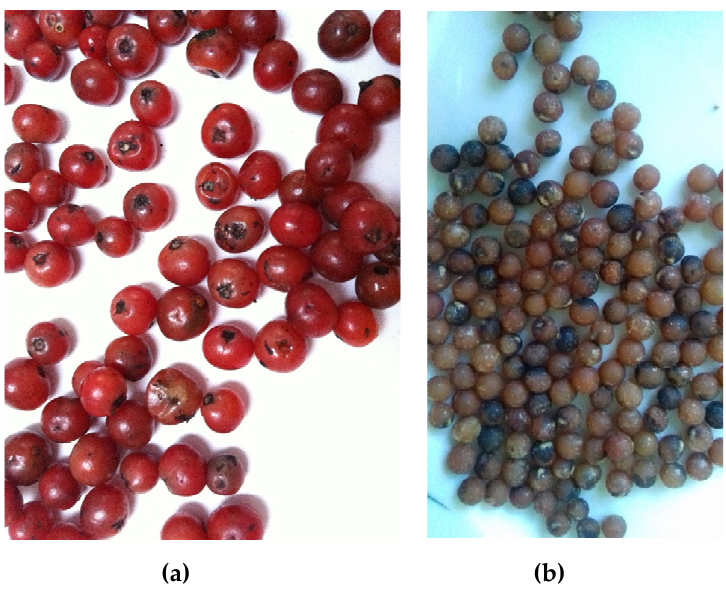
Figure 1. Fruits ( a ) and seeds ( b ) of Dracaena cinnabari.